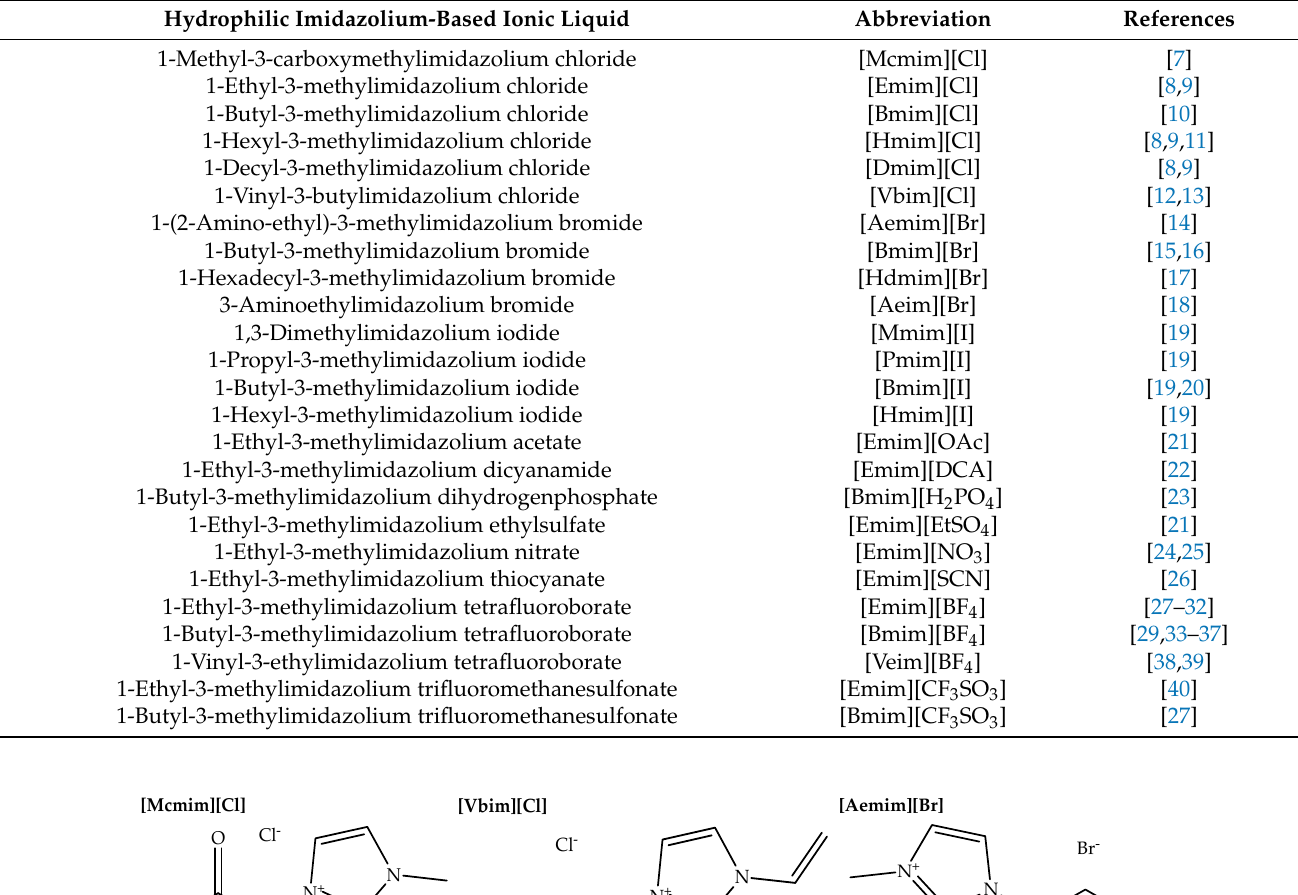
Table 1. Examples of hydrophilic imidazolium-based ionic liquids utilized for preparation of PVDF and PVDF-HFP blends and composites.